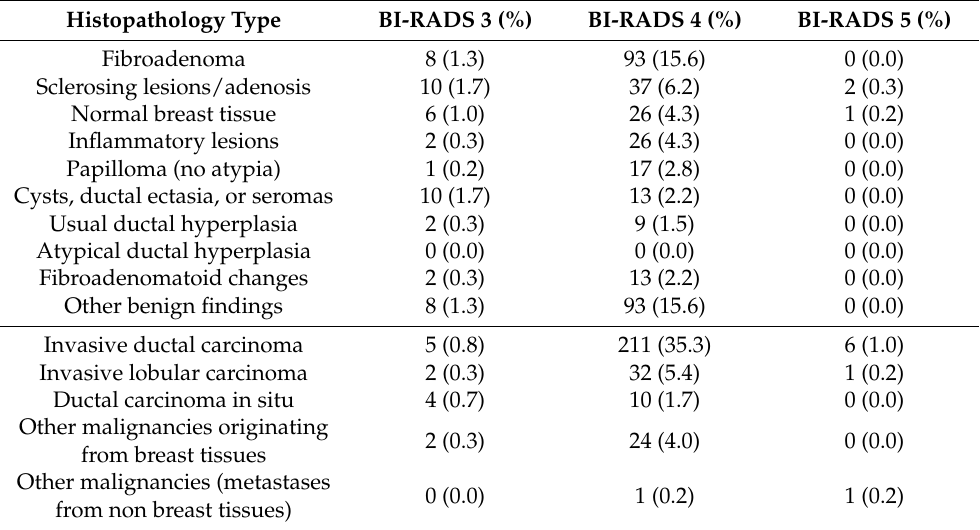
Table 5. Ensemble of support vector machines: BI-RADS diagnostic categories predicted for breast masses of the Training and internal testing set according to histopathology groups.